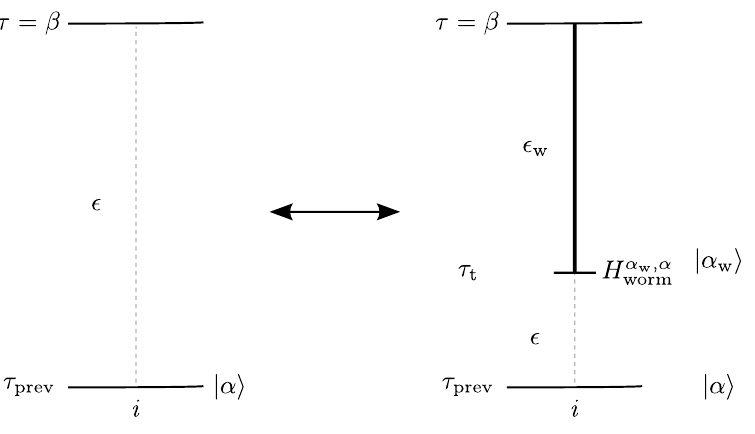
Figure 3: Insert / Delete worm from τ = β . A worm is inserted at the τ = β edge by inserting a worm tail at a randomly sampled time τ particle to the segment spanning the interval τ : [ τ be inserted by placing a worm head at the sampled time and destroying a particle in the segment τ : [ τ , β ) h